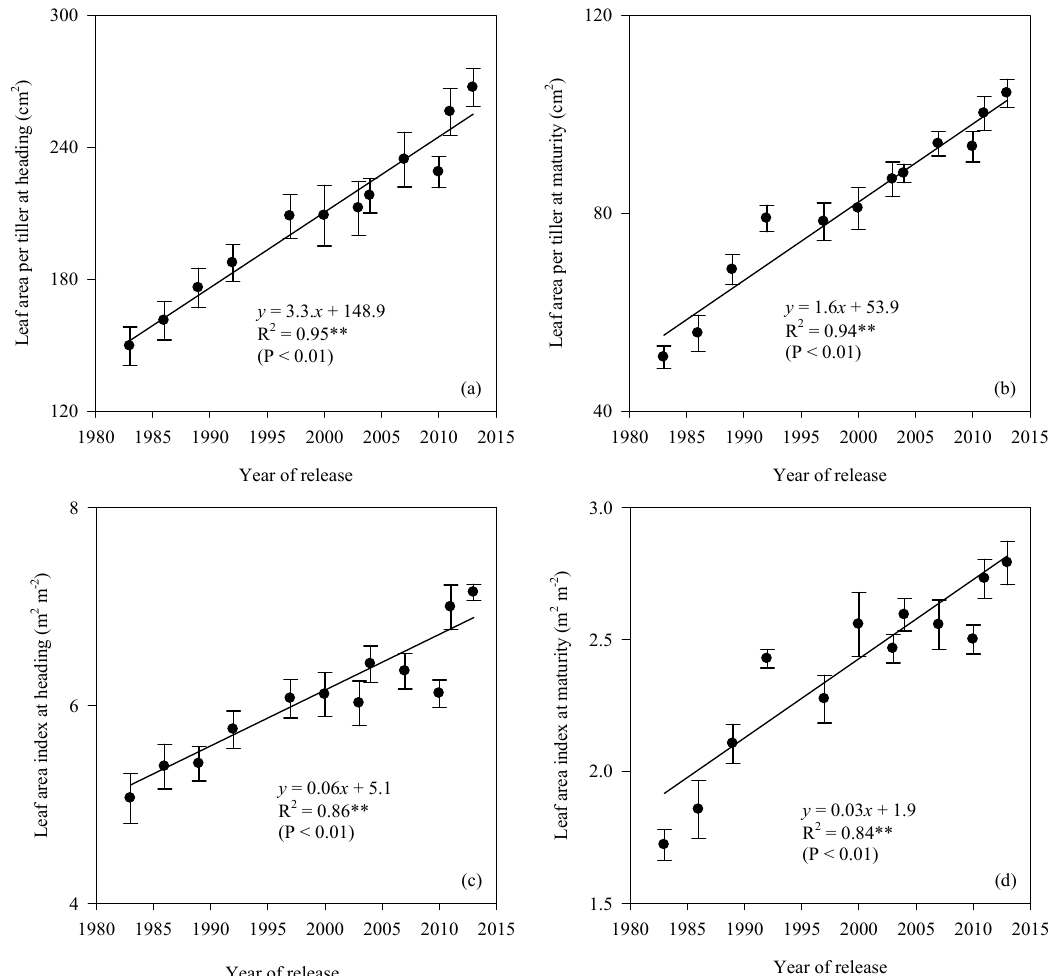
Figure 6. Relationships between year of release and leaf area per tiller ( a , b ), and leaf area index ( c , d ) at heading and maturity of rice cultivars. Data were fitted by linear regression ( y = a x + b). In the linear regression, x was reassigned as years after 1983; for example, x was valued as 1 in 1983 and so on. **, significant at the 0.01 probability level according to the LSD test. Vertical bars represent ± standard error of the mean ( n = 6).